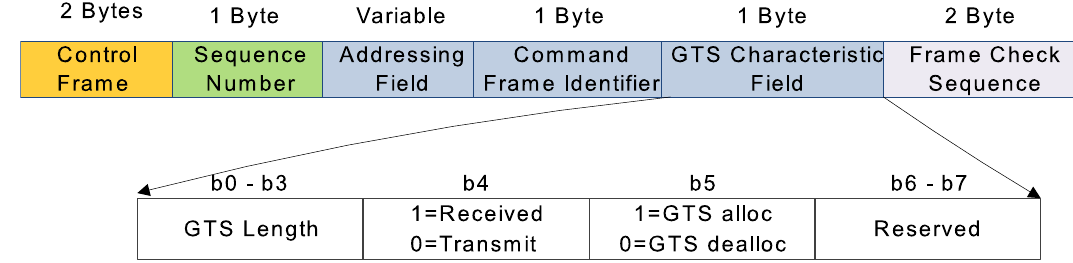
Figure 3. GTS request frame format of IEEE